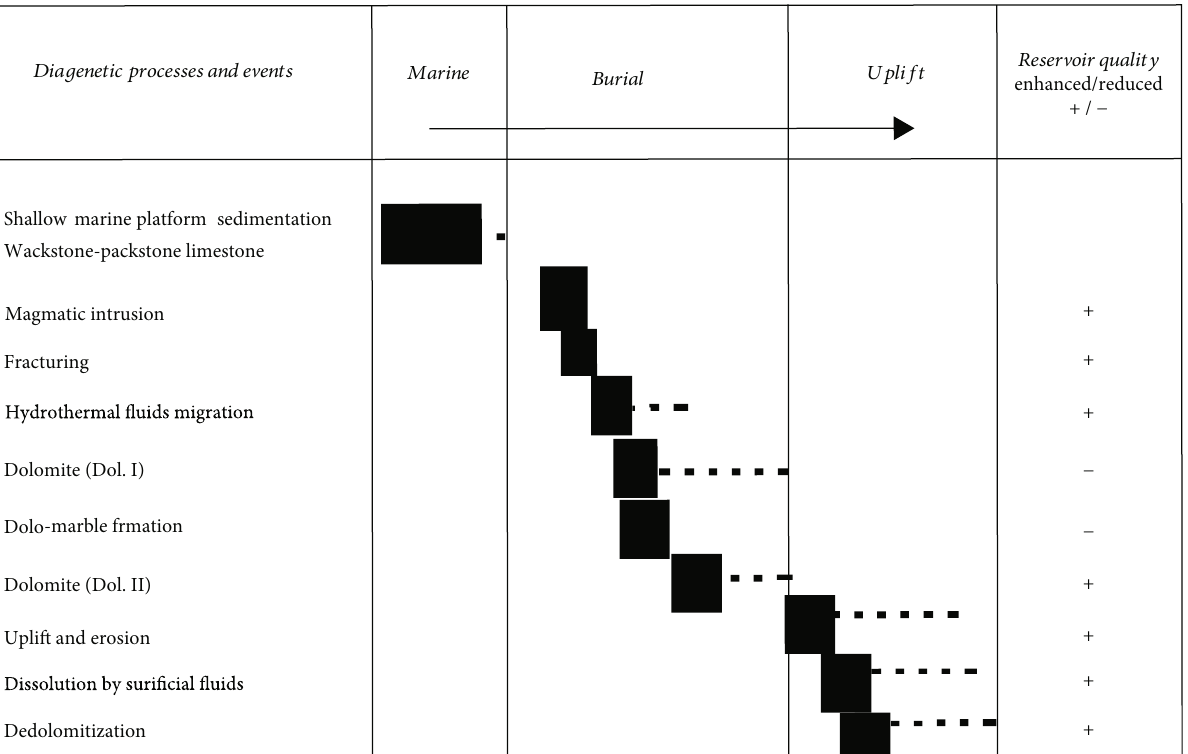
Figure 12: Paragenetic sequence showing various diagenetic phases within the carbonate succession and its relationship with the evolution of petrophysical